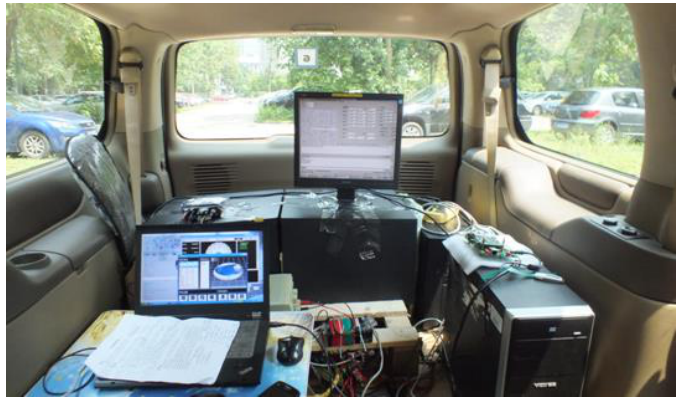
Figure 6. Experiment environment based on vehicle.